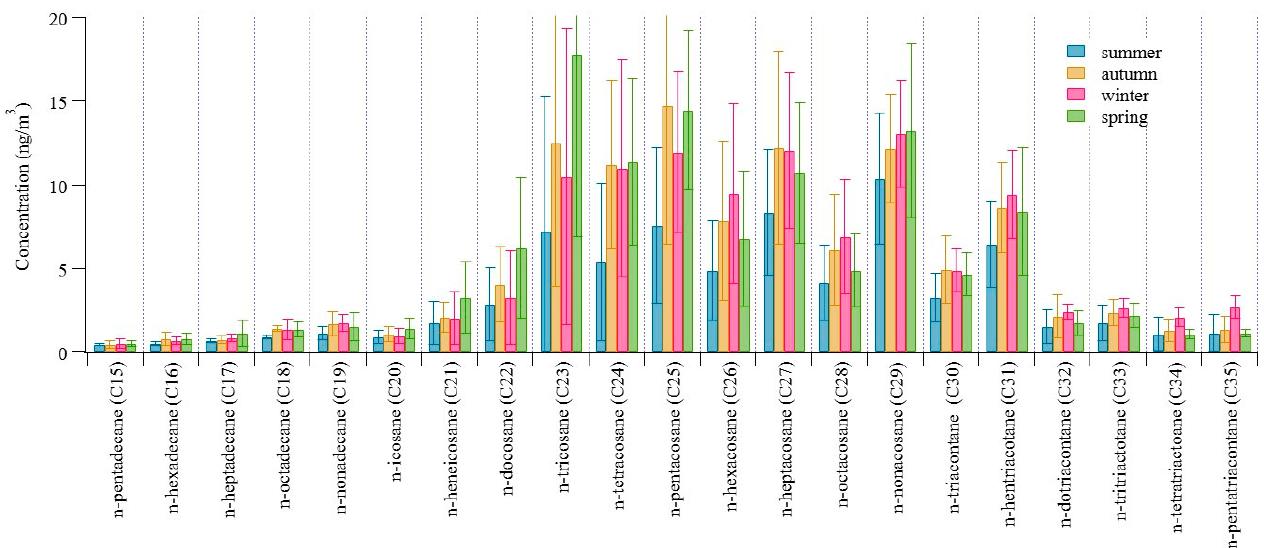
Figure 4. Relative concentration of n -alkane species in different seasons (unit: ng/m 3 ; blue: summer, yellow: autumn, red: winter, green: spring).